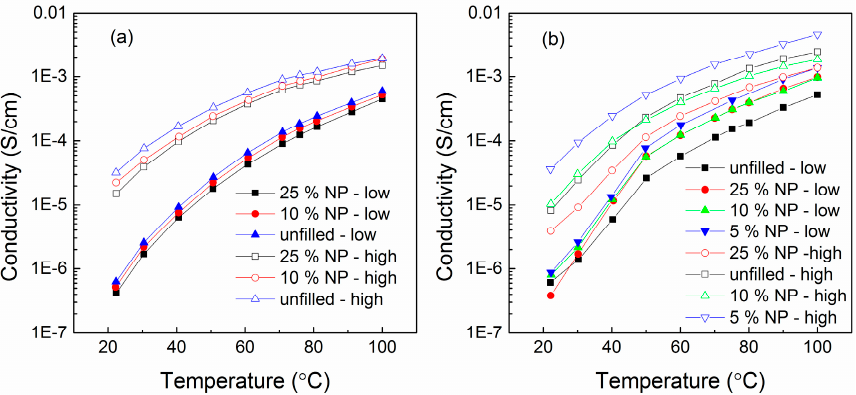
Figure 21. Conductivity vs. temperature at varying nanoparticle concentrations for samples held under conditions of high ( empty symbols ) and low ( filled symbols ) humidity at an EO:Li + ratio of ( a ) 8:1 and ( b ) 10:1. Data from Fullerton-Shirey et al. [185].